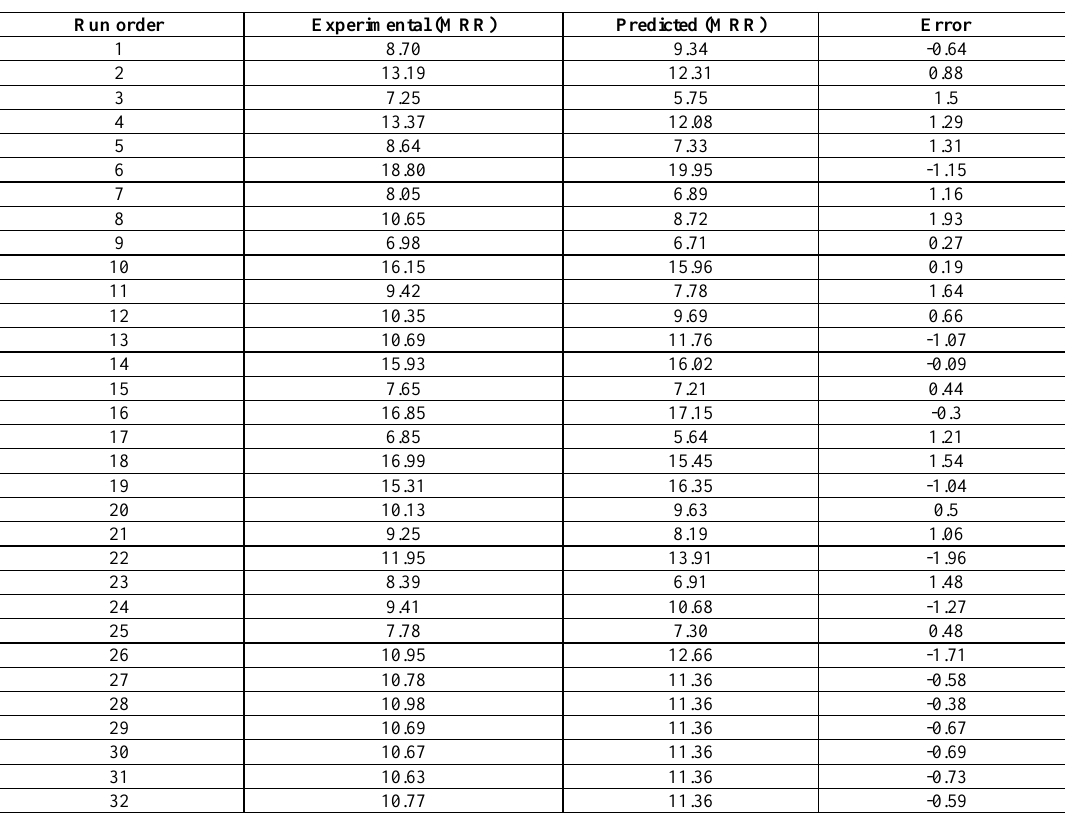
Table 8. The error between the anticipated and the exploratory outcomes Run